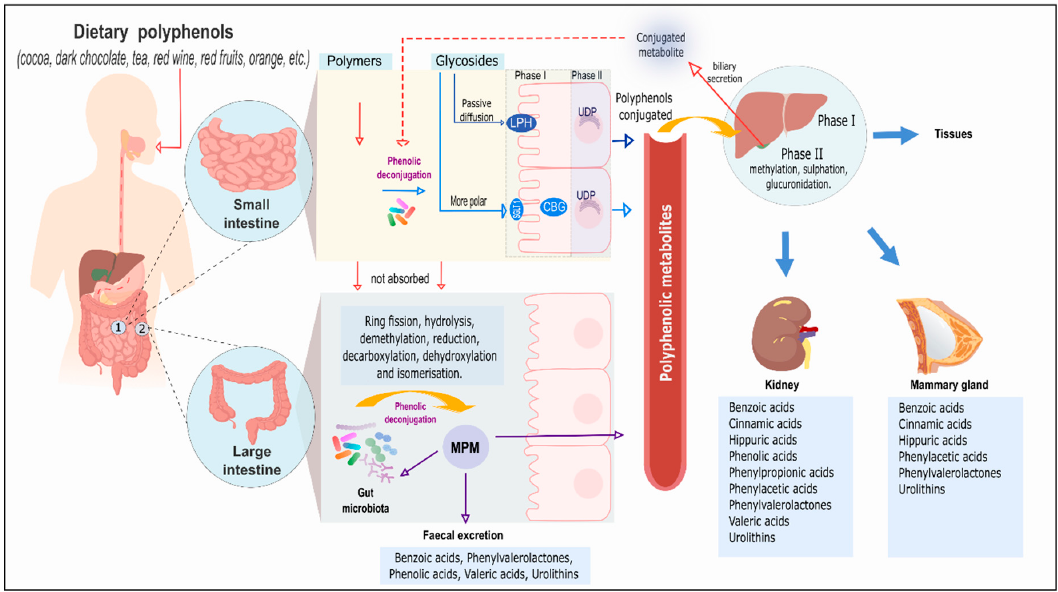
Figure 1. Metabolic pathways of polyphenols produced by the human gut microbiota. LPH: lactase-phlorizin hydrolase; CBG: cytosolic β -glucosidase; UDP: uridine 5’-diphospho-glucuronosyltransferase; MPM: microbial phenolic metabolites.